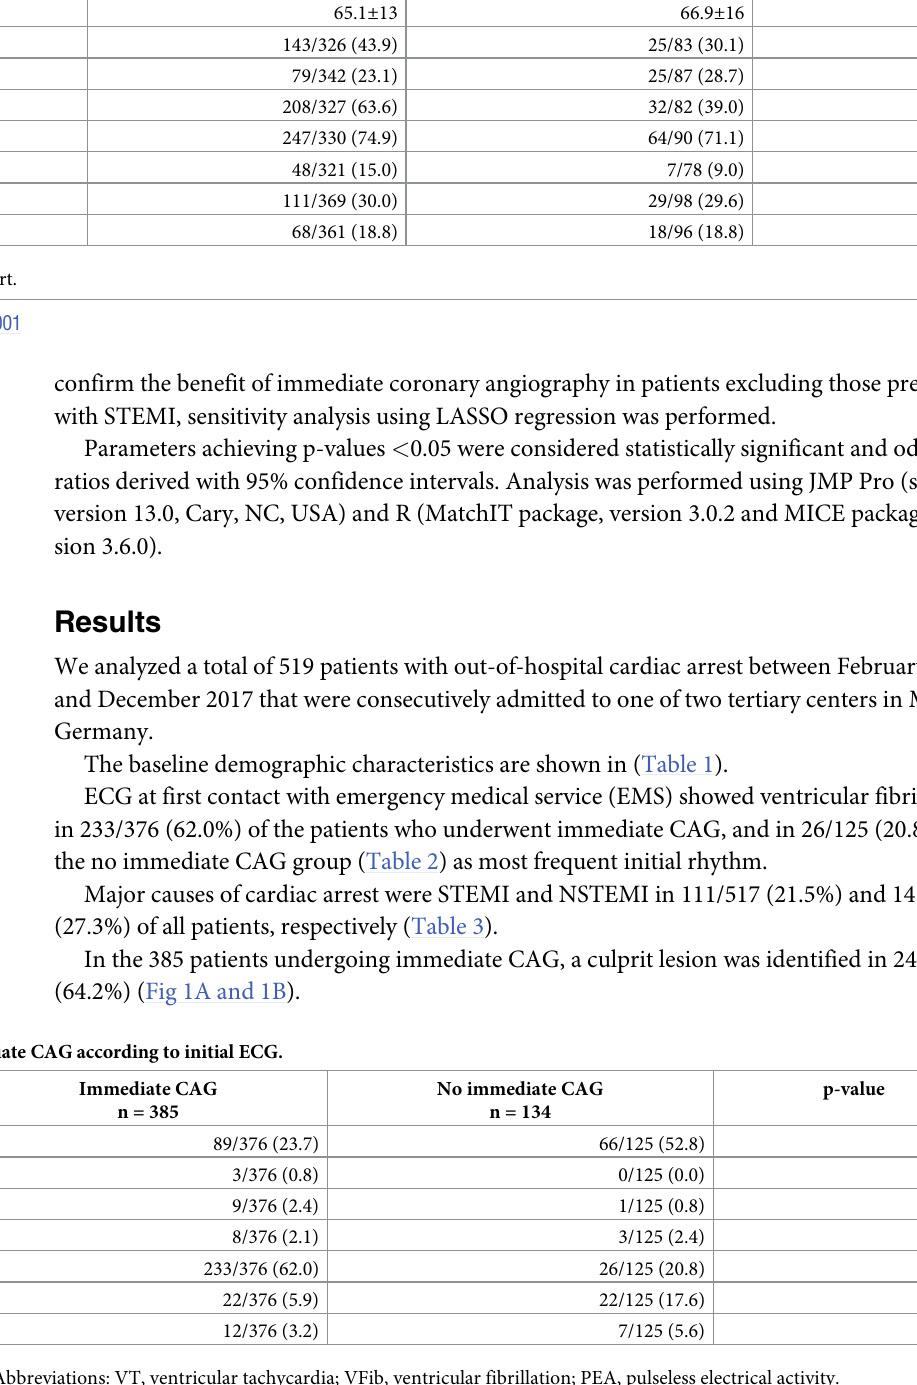
Table 1. Baseline characteristics of patients with and without immediate CAG.